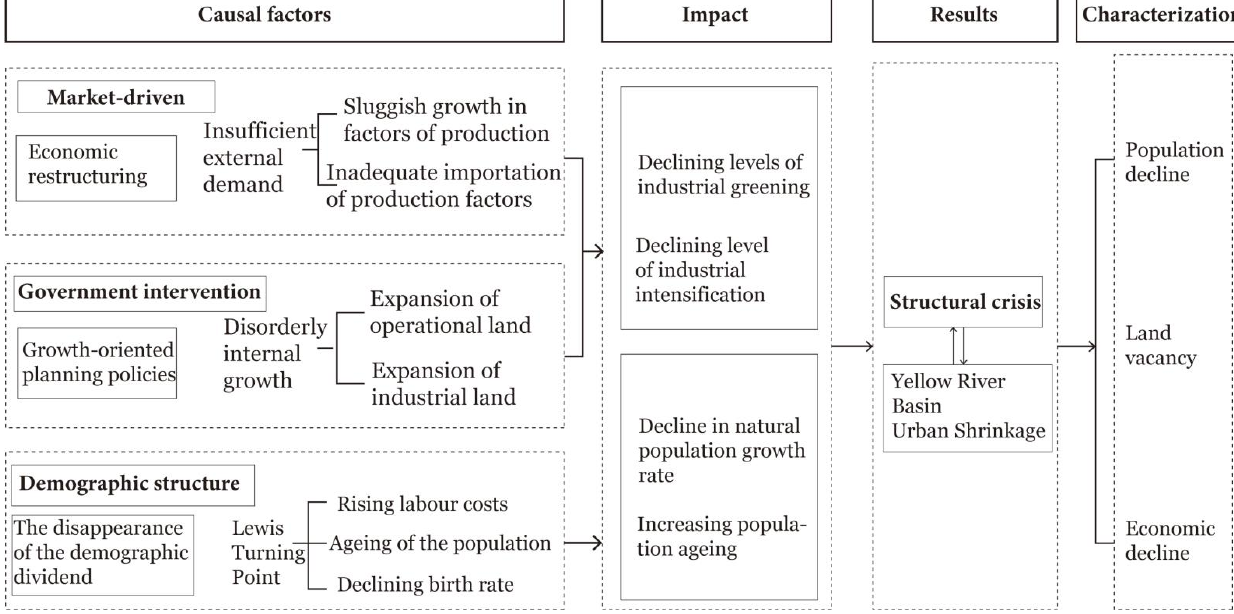
Figure 6. Urban shrinkage mechanism in the Yellow River Basin.